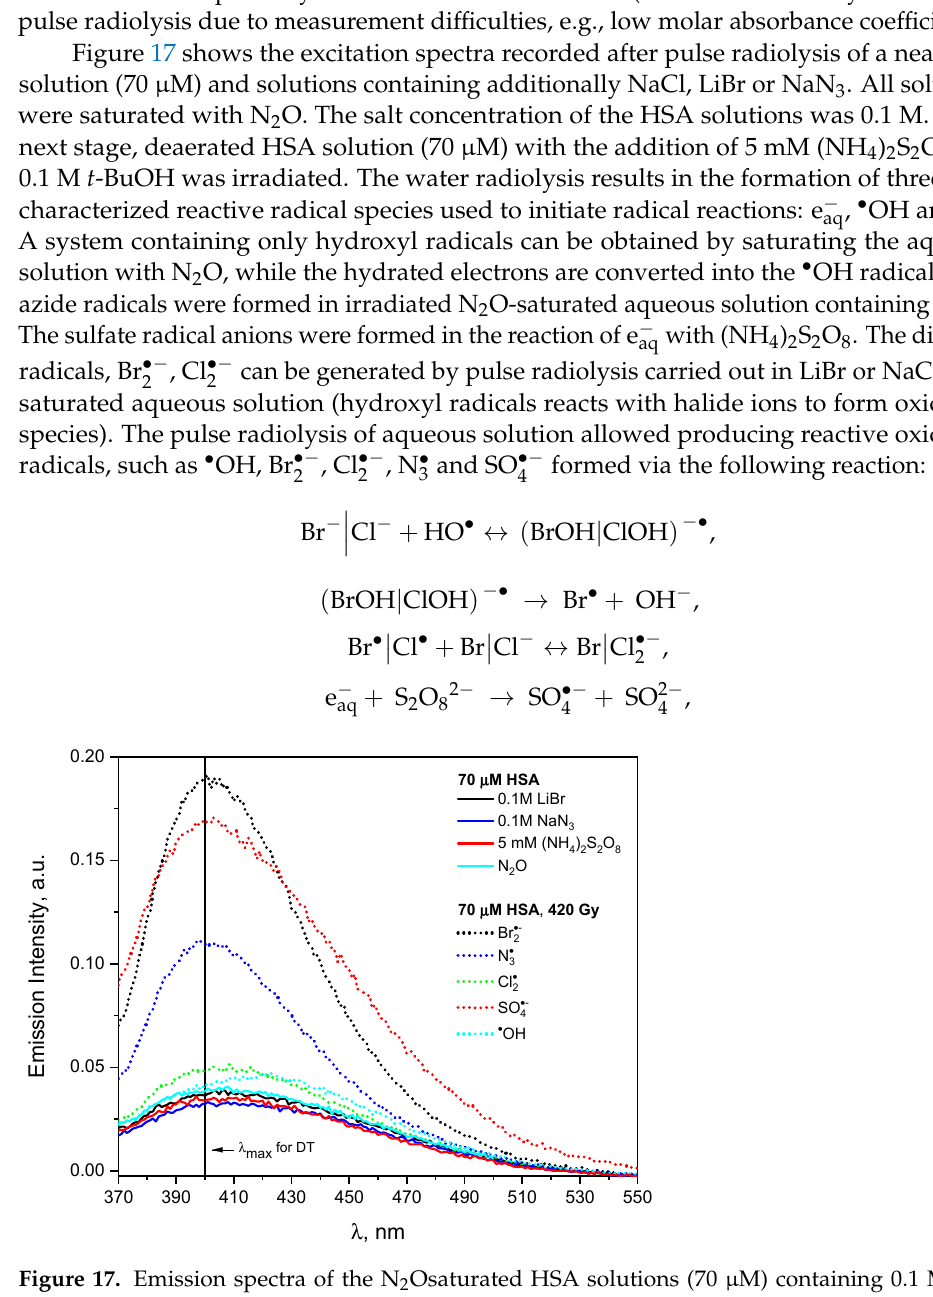
Figure 17. Emission spectra of the N 2 Osaturated HSA solutions (70 µM) containing 0.1 M LiBr, 0.1 M NaCl, 0.1 M NaN 3 , 5 mM (NH 4 ) 2 S 2 O 8 recorded before and after irradiation with a dose 420 Gy. t-BuOH was added to the HSA solution containing (NH 4 ) 2 S 2 O 8 . The excitation wavelength was 320 nm. The vertical line shows λ max for DT (400 nm).